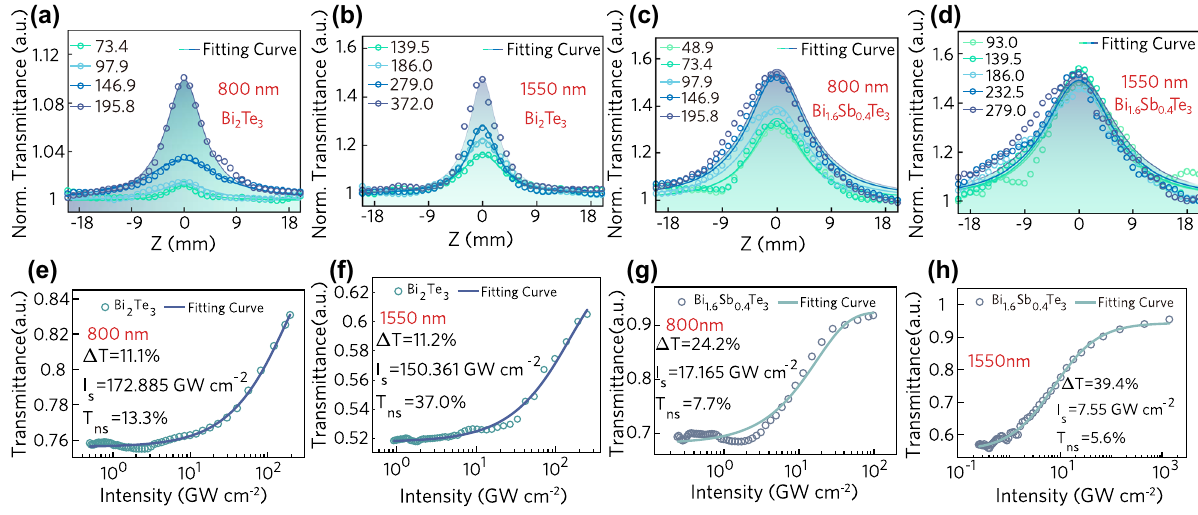
Te and Bi Sb Te . 2 3 1.6 0.4 3 Te at 800 nm and 1550 nm (the unit of numbers in the legend is GW cm − 2 ), (c)–(d) Z-scan results of Bi 2 3